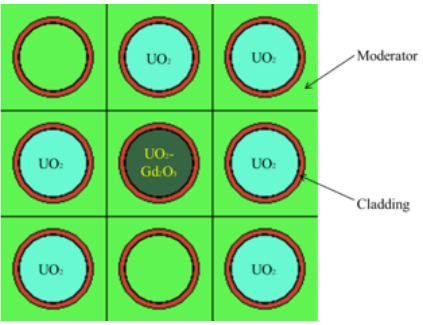
Figure 1. The SF96 benchmark model